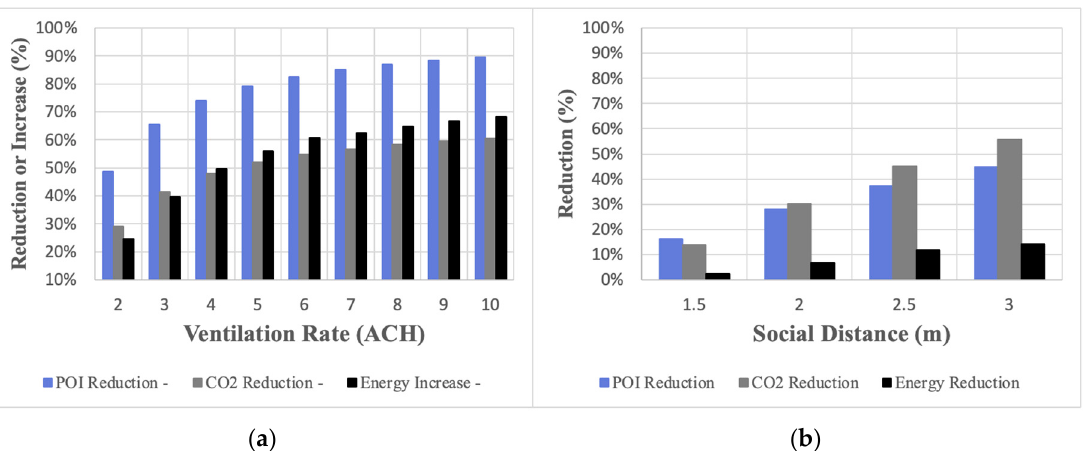
Figure 12. Percentage of change in POI, CO 2 concentration, and cooling energy due to change in ( a ) ventilation rate and ( b ) social distance for July 22 nd .